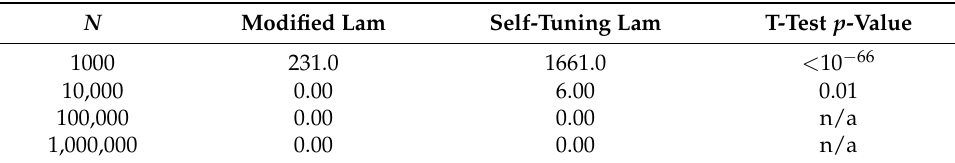
Table 4. Average solution cost for the OneMax problem, case when each 0-bit costs 100.